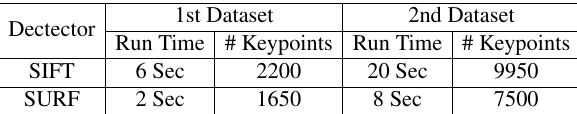
Table 1. Comparison of SIFT and SURF keypoints detection and